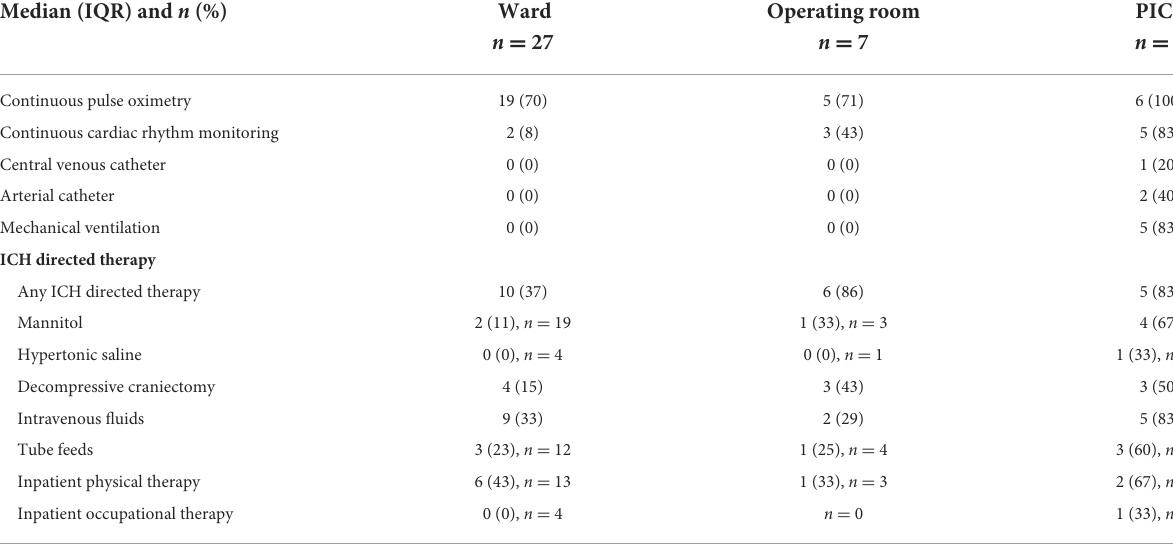
TABLE 3 Inpatient monitoring and interventions separated by highest level of care. Median (IQR) and n